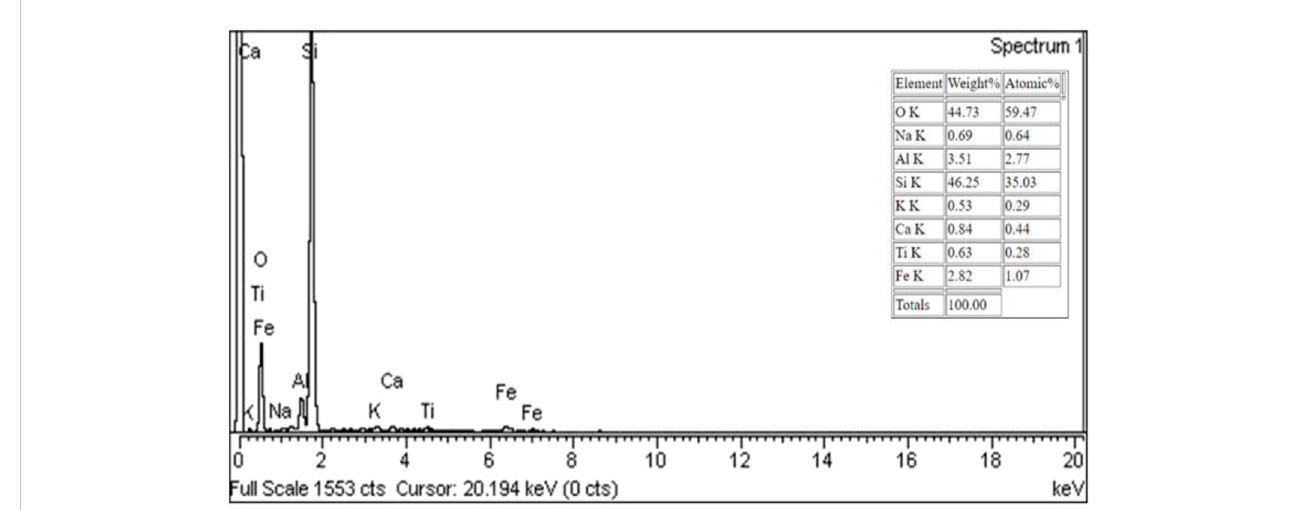
FIGURE 15 EDX analysis of DC3 mix at ambient temperature.